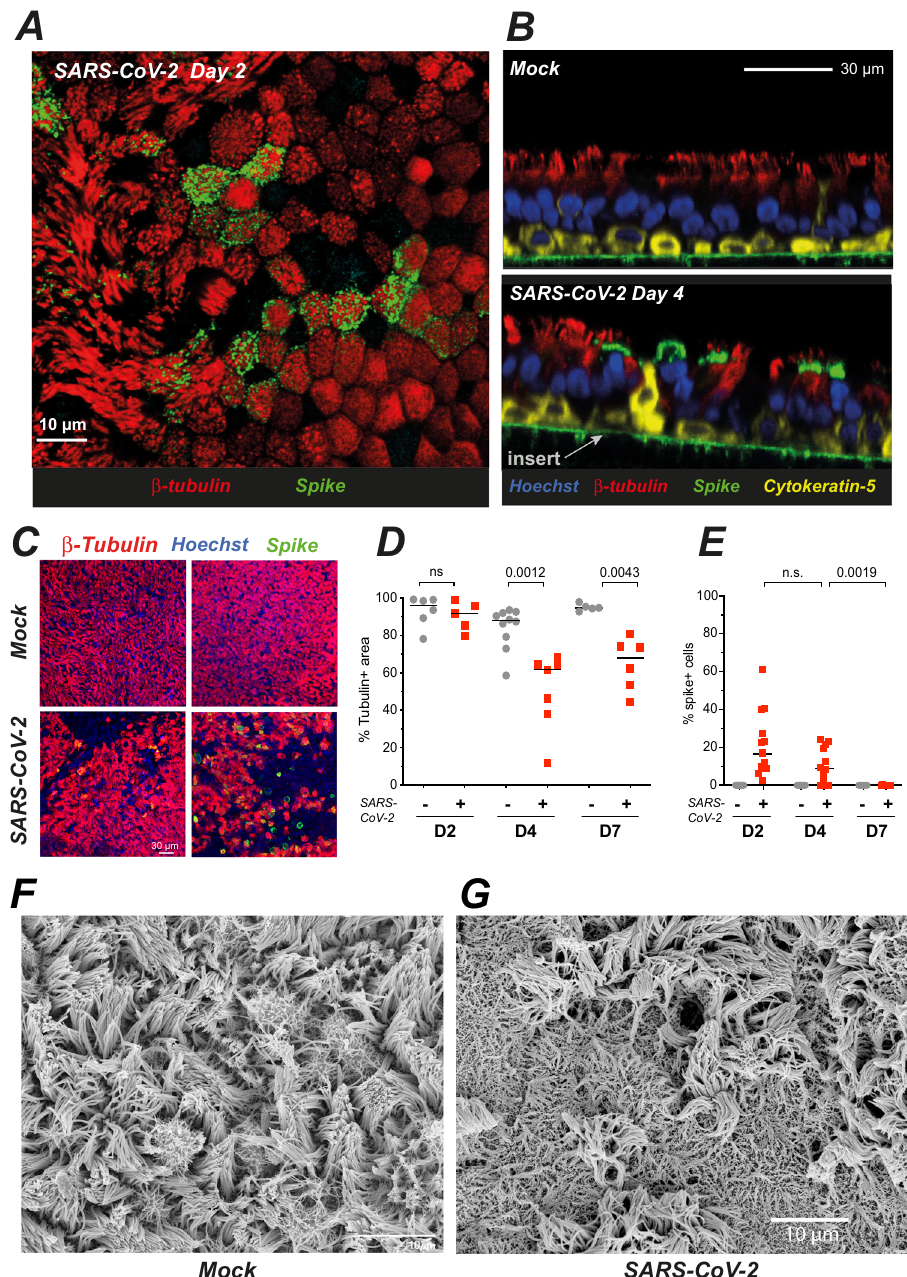
Fig. 2 SARS-CoV-2 preferentially targets ciliated cells and damages the ciliary layer. A, B Confocal imaging of a SARS-CoV-2-infected epithelium at 2 dpi ( A , top section) and of control (Mock) and infected epithelia at 4 dpi ( B , orthogonal sections). Ciliated cells are labeled for β -tubulin IV (red), basal cells for cytokeratin-5 (yellow), nuclei for DNA (Hoechst, blue), and infected cells for the SARS-CoV-2 spike (green). The green line in 2B is due to the auto fl uorescence of the insert porous membrane. C, D Representative images of the β -tubulin layer at 4 dpi ( C ) and corresponding image analysis ( D ) ( n = 3 independent experiments with 1 – 4 replicates for D4; n = 2 independent experiments with 2 – 3 replicates for D2 and D7; Mann – Whitney test). E Percentage % of spike + cells, measured as (number of spike + cell/number of nuclei) × 100 ( n = 5 independent experiments with 1 – 5 replicates for D2 and D4; n = 3 independent experiments with 3 replicates for D7; Mann – Whitney test). F, G SEM imaging of mock-infected ( E ) and SARS-CoV-2-infected ( F ) reconstructed epithelia at 4 elongated axonemes that emerged from basal bodies aligned pleiomorphic (Fig. 3E), consistent with studies suggesting that perpendicular to the plasma membrane (Fig. 4A). The basal spike trimers adopt various orientations at the virion surface 32 . Transmission electron microcopy (TEM) was then used to bodies were themselves anchored into the cytoplasm through examine the internal organization of cilia. Mock-infected epithelia striated rootlets (Supplementary Fig. 5B). A striking dis- revealed a typical “ 9 + 2 ” cilium structure, with peripheral organization of cilia structure was observed in SARS-CoV-2- microtubule doublets surrounding a central microtubule pair infected cells, with fewer axonemes, and misoriented basal bodies (Supplementary Fig. 5 A). These microtubules constituted that lined large vesicles, which themselves often contained viral-